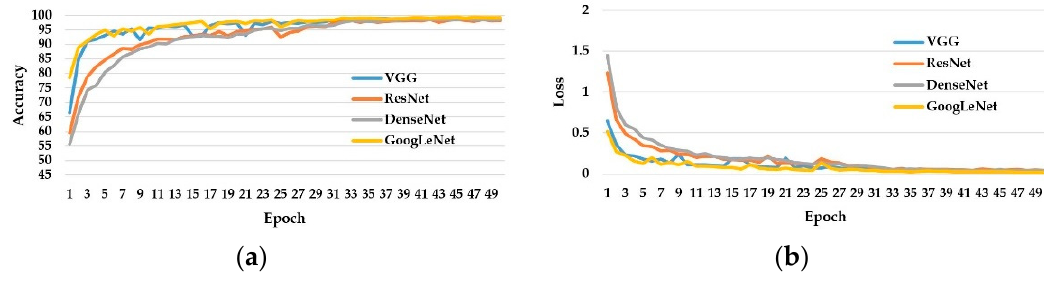
Figure 15. Training curve for casting dataset. ( a ) Model Accuracy, ( b ) Model Loss. Table 6. The average training time for one epoch.